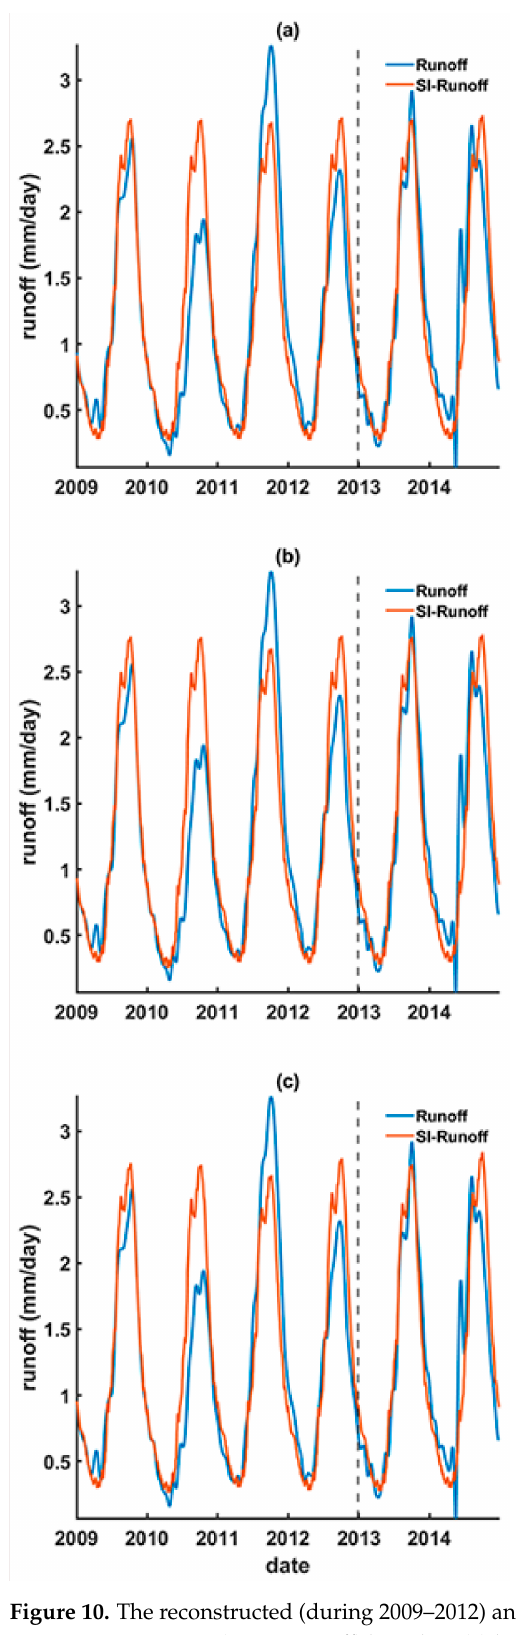
Figure 10. The reconstructed (during 2009–2012) and forecasted (during 2013–2014) runoff using the upstream GRACE SI (i.e., SI-runoff) based on ( a ) linear regression, ( b ) ANN, and ( c ) LSTM